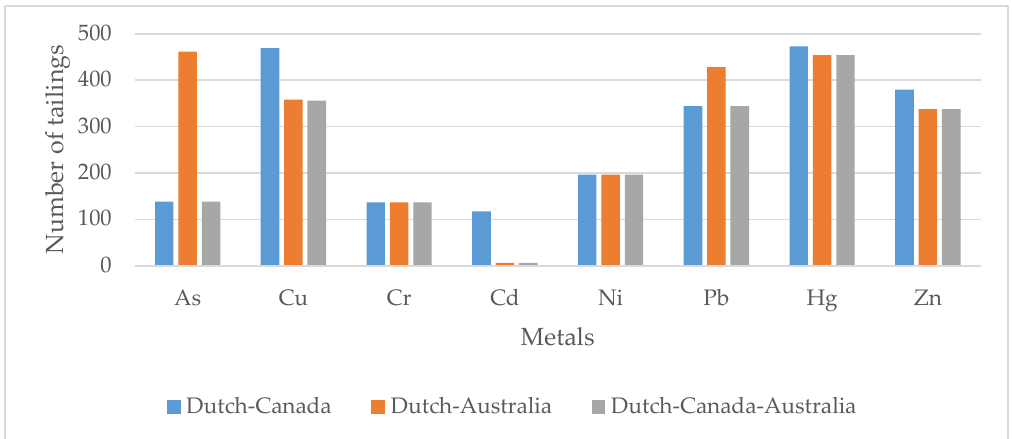
Figure 2. Comparison of results by applying the Canadian and Australian guidelines and the adapted Dutch norm to 530 tailings.